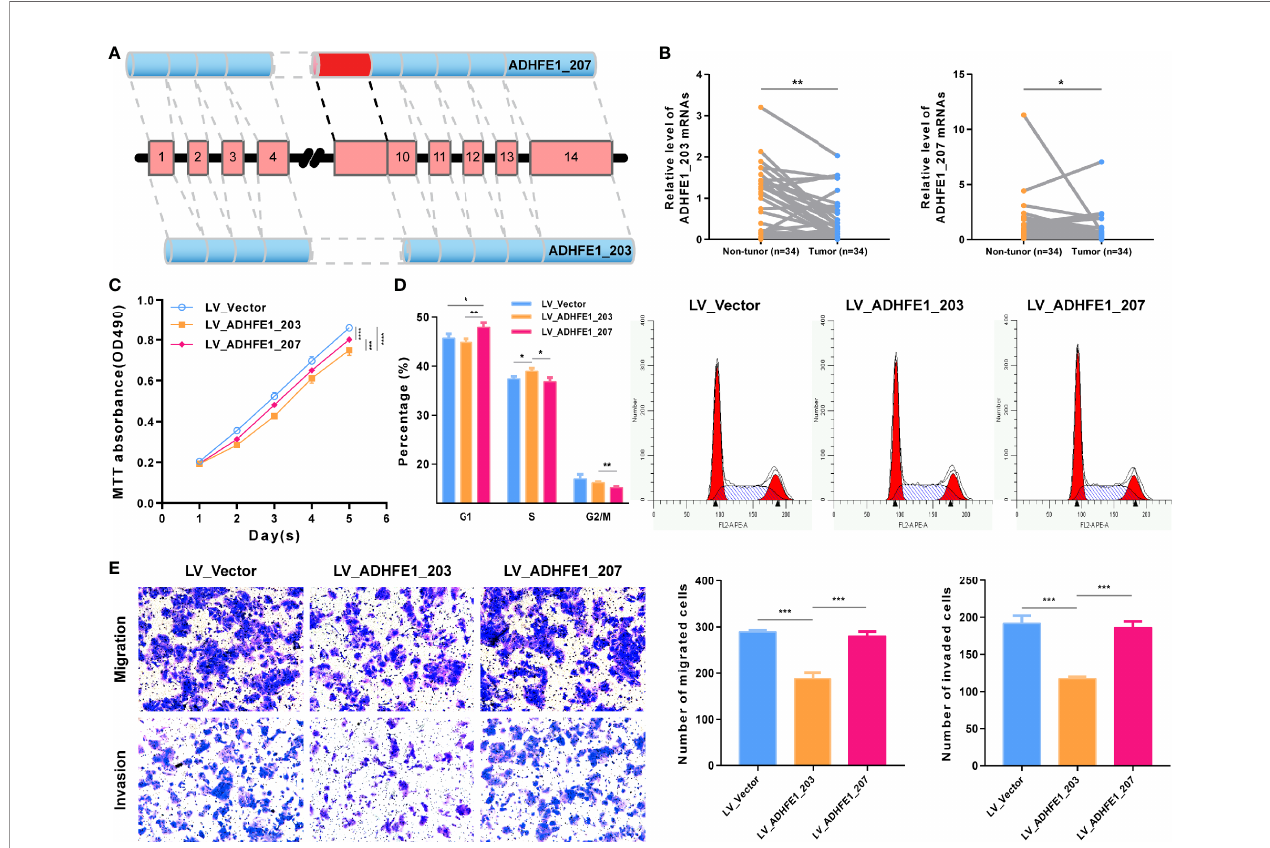
FIGURE 7 | Functional experiment of ADHFE1 splicing variants in HCC cell. (A) The splicing pattern of ADHFE1_203 (ENST00000396623.8) and ADHFE1_207 (ENST00000424777.6). (B) The RNA expression of ADHFE1_203 and ADHFE1_207 in matched HCC and adjacent non-tumor frozen tissues. (C – E) MTT assay (C) , Cell Cycle analysis (D) , and Transwell assays (E) . *P < 0.05, **P < 0.01, ***P < 0.001, ****P <